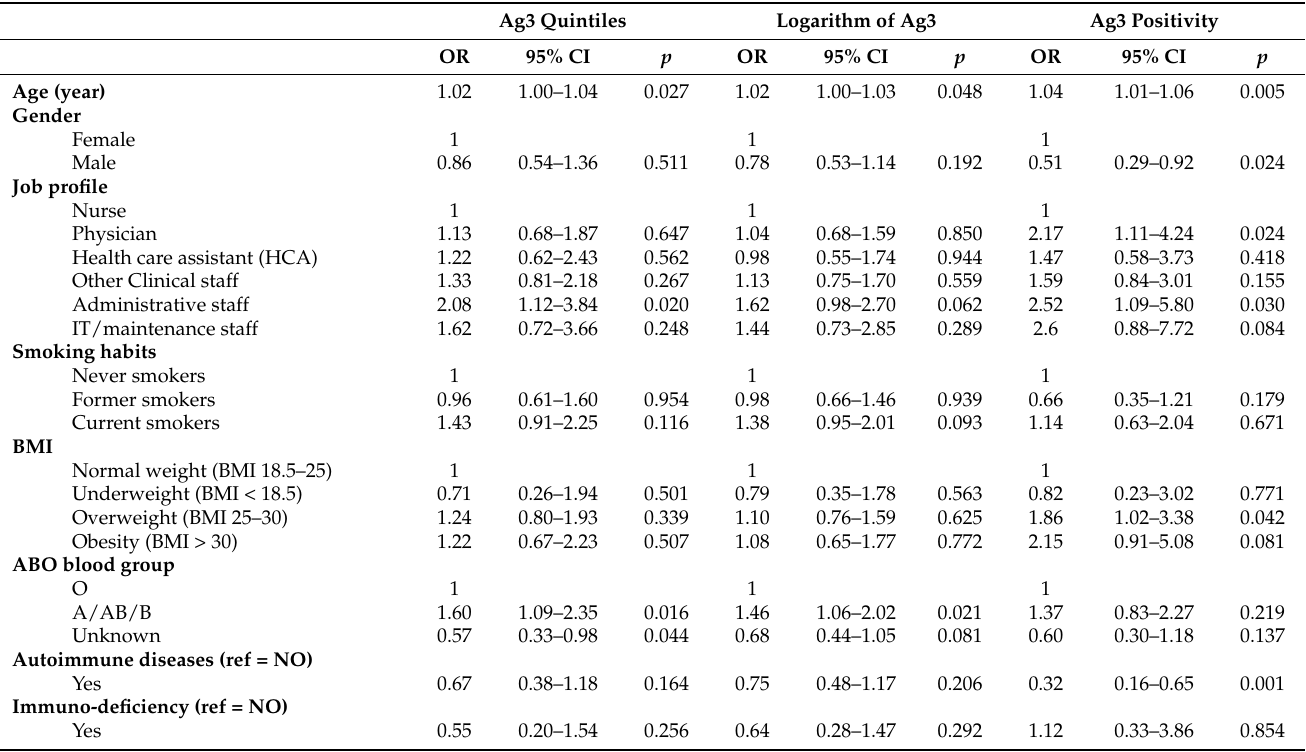
Table 5. Multivariable analyses (ORs and 95% CI) for the predictors of Ag3 cellular response among 419 vaccinated HCW of CSS, using different outcomes: quintiles of Ag3 (low vs. high, ordinal logistic regression, first column); logarithm of Ag3 (second column); positivity of Ag3 (third